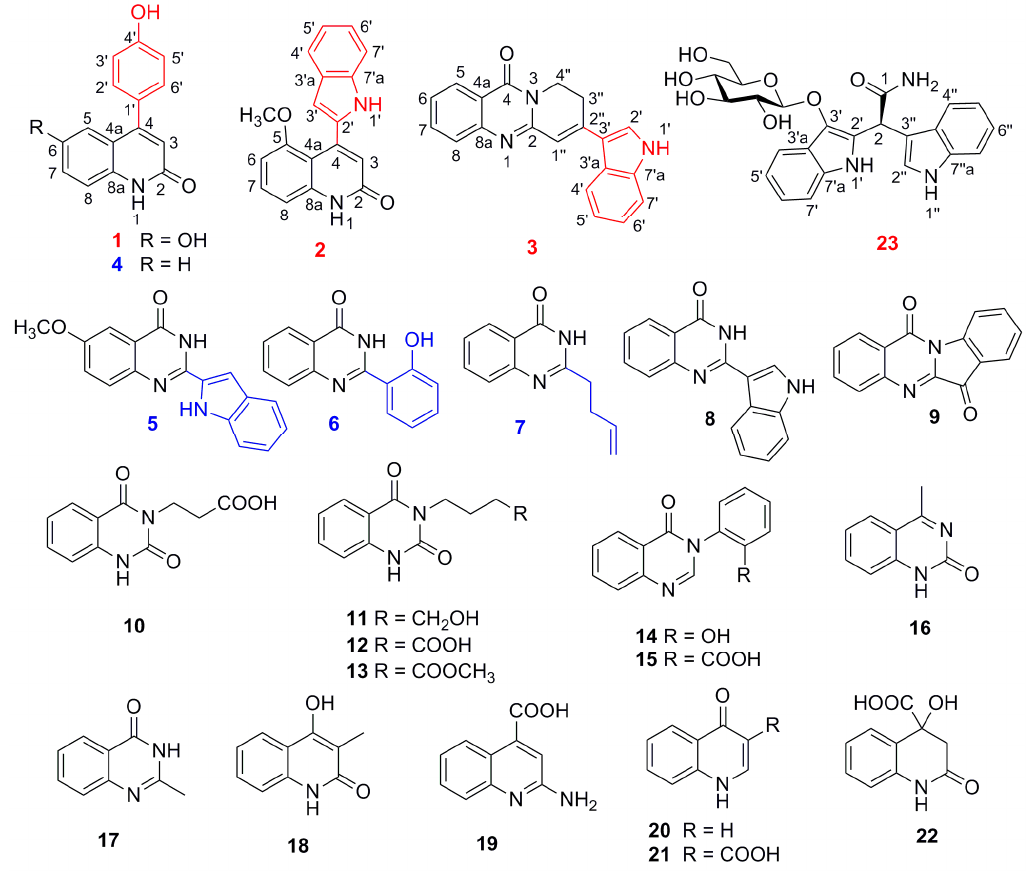
Figure 1. Structures of Compounds 1 – 23.